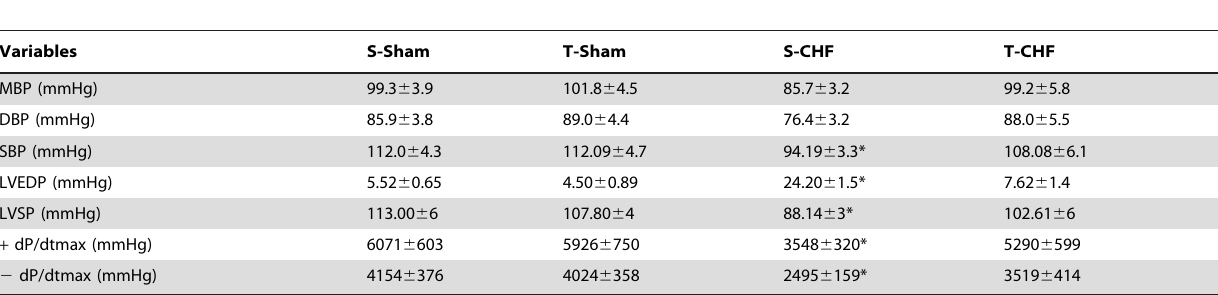
Table 2. Mean blood pressure, diastolic blood pressure, systolic blood pressure, left ventricular end-diastolic pressure, ventricular systolic pressure, left ventricular maximum change in pressure over time and left ventricular minimum change in pressure over time of sham-operated rats and rats with left ventricular